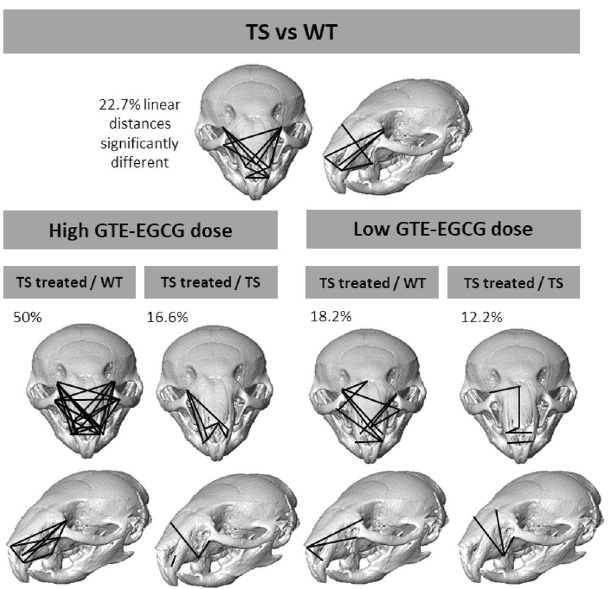
Figure 2. Localized Euclidean Distance Matrix Analysis facial shape pairwise contrasts for each mouse group of untreated wildtype (WT) and trisomic (TS) mice and low and high dose GTE-EGCG-treated mice. Results from the baseline contrast (TS vs WT) can be compared to results from high and low GTE-EGCG dose experiment to assess the effect of the treatment on Ts65Dn facial skeleton development. Black solid lines represent linear facial measurements that are significantly different in the two compared groups. Numbers indicate the percentage of significantly different linear distances within each comparison. Mice skull reconstructions were obtained from NRecon and